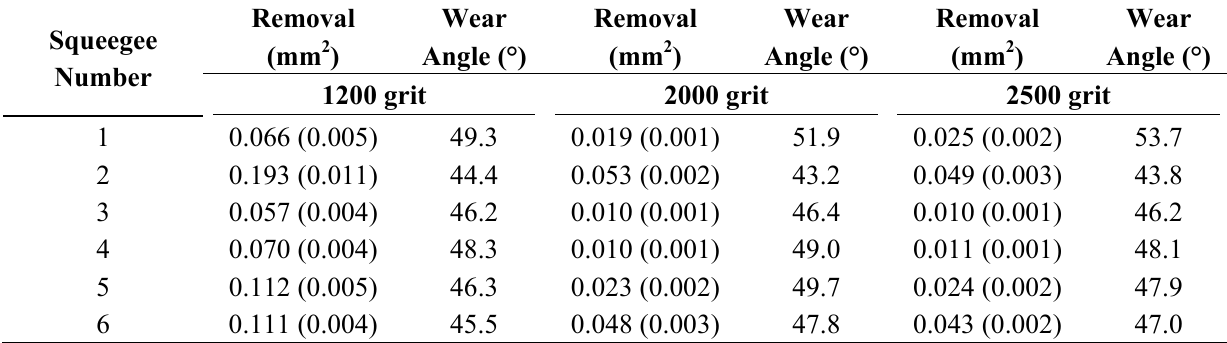
Table 5. Squeegee cross-sectional area removed and wear angle after 50 wear cycles with different silicon carbide abrasives. Standard deviation shown in parentheses.